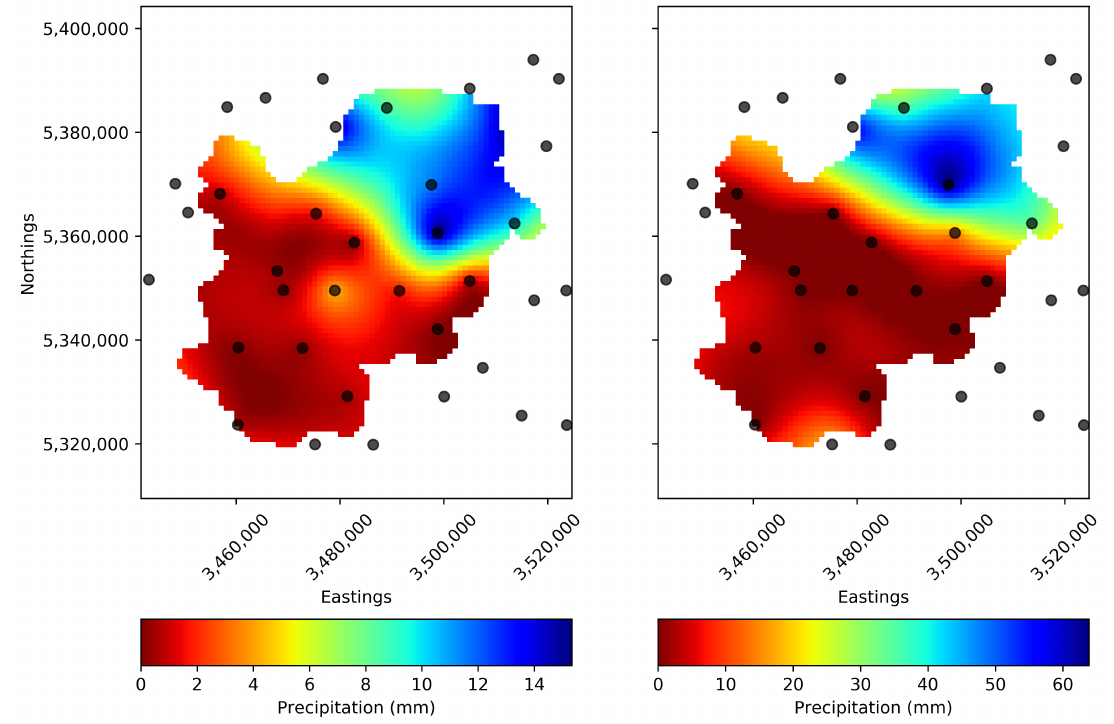
Figure 14. Observed precipitation ( left ) interpolated from observed data on 11 May 2009 and interpolated ( right ) using simulated values (VV7) at the observed locations on 24 December